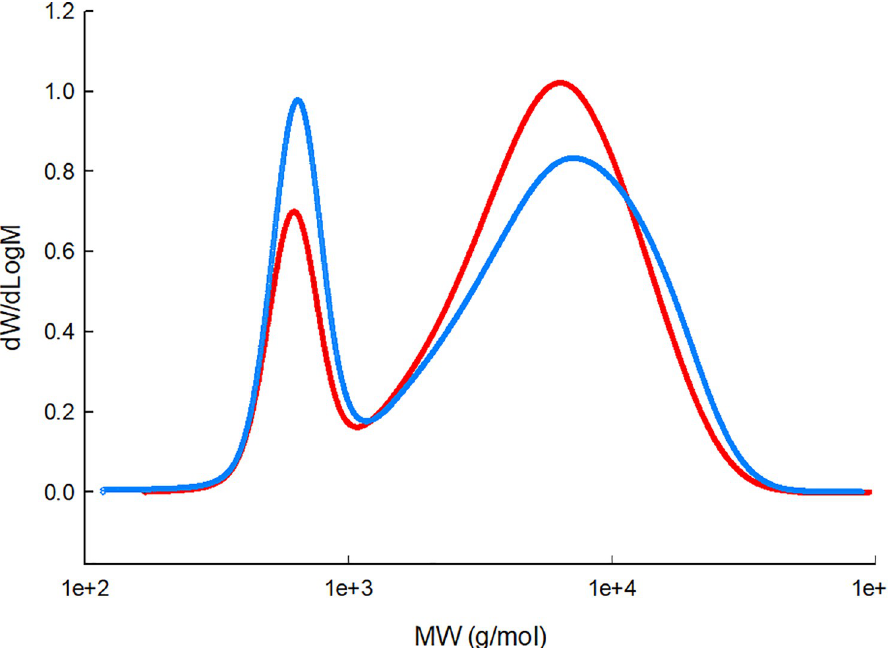
Fig 5. Molecular weight distribution of polysiloxanes produced via protocol 2. Ring-opening polymerization following “protocol 2” produced two liquid polysilioxanes that spontaneously separate in two phases with different densities and are referred as fluid C (red) and fluid D (blue). Each fluid exhibits bimodal molecular weight distribution. https://doi.org/10.1371/journal.pone.0252361.g005 weight fraction (150˚C, 23 mm Hg) with a density of 1.0565 g/mL. The remaining fluid (~ 53 mL) consists of a high molecular weight fraction with density 1.031 g/mL; this remained undistilled up to 200˚C at 23 mm Hg). Table 1 lists molecular weight values for different fractions. Reported molecular weight moments and polydispersity from the overall chromatogram, as average +/- one standard deviation. Molecular weights are reported in polystyrene equivalents.